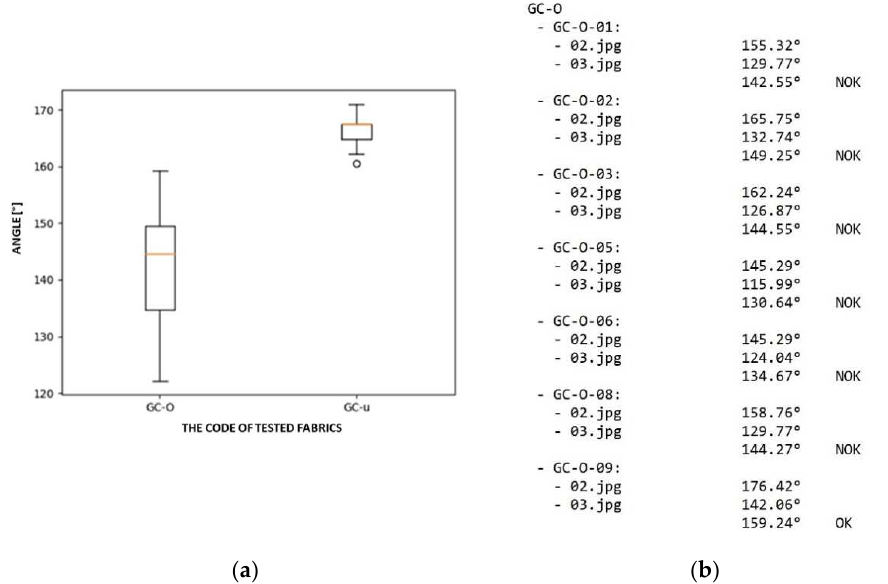
Figure 14. The example of results of the examined textiles: ( a ) the box diagram of results; ( b ) meas- urement results saved as a text file for the tested fabric type GC-O. ( b ) measurement results saved as a text file for the tested fabric type